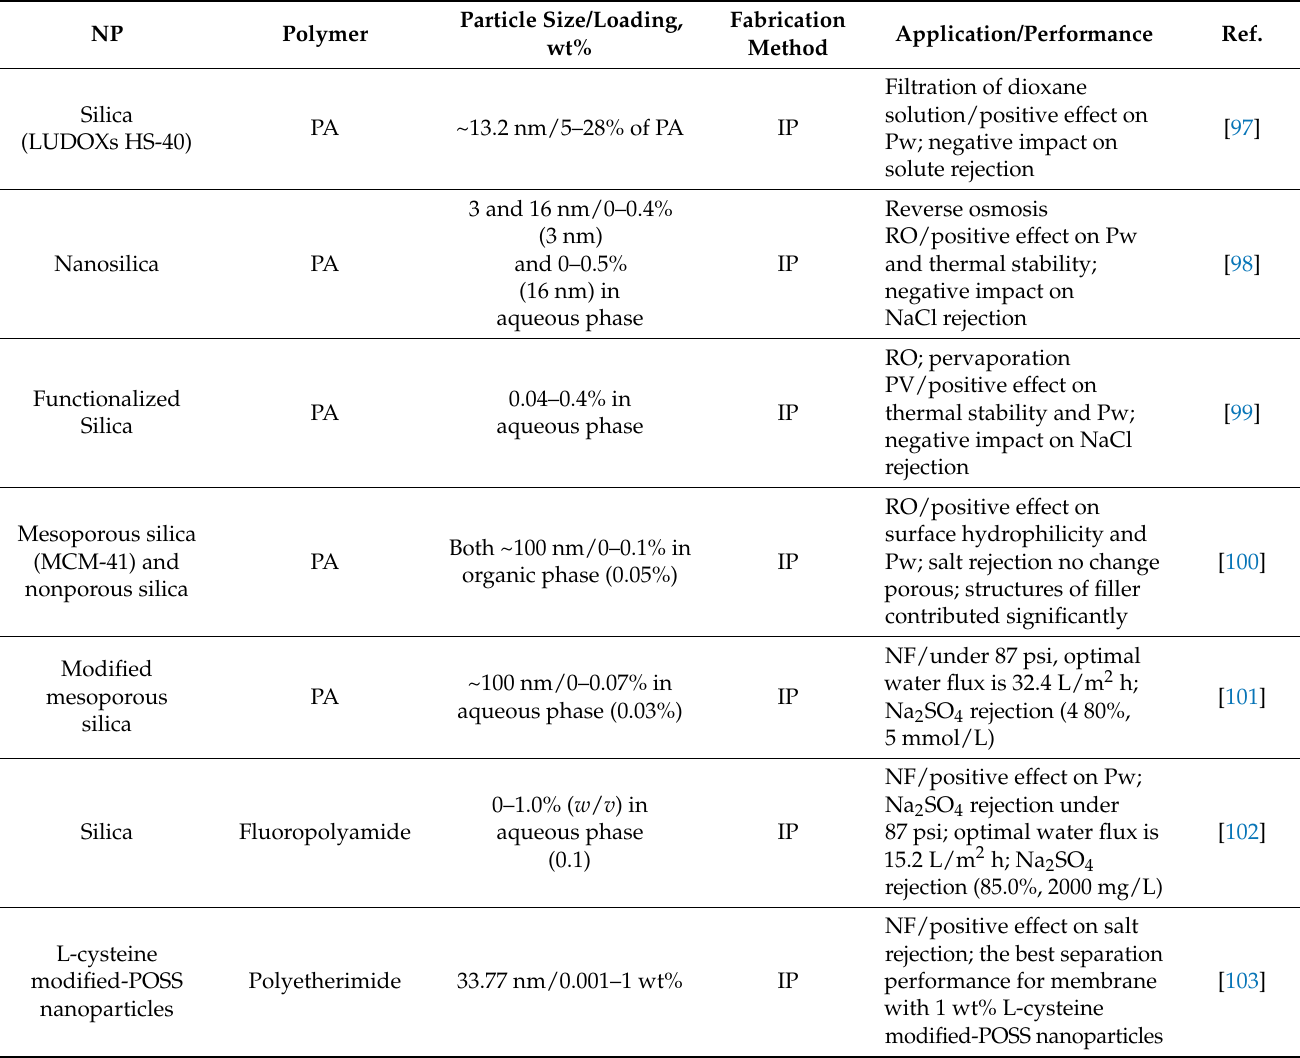
Table 3. Selected applications of various types of silicas in